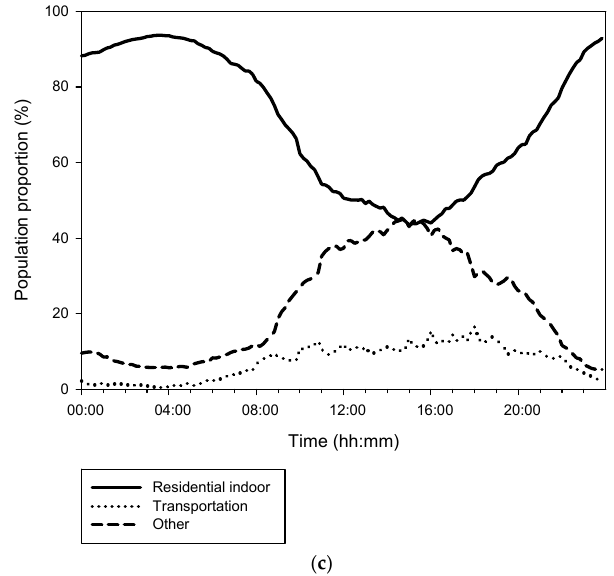
Figure 2. Time–activity patterns of the surveyed residents of Seoul on ( a ) weekdays, ( b ) Saturdays, and ( c ) Sundays.